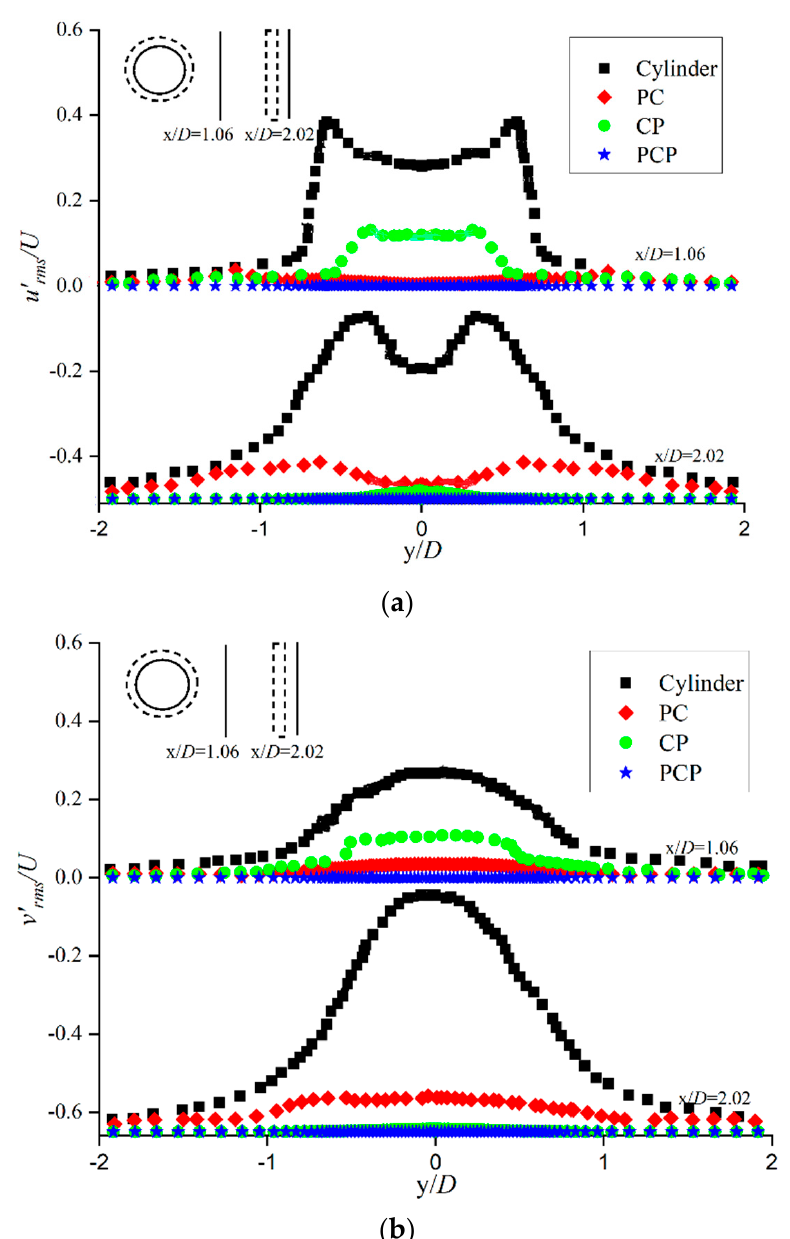
′ (cid:3293)(cid:3288)(cid:3294) (cid:48) (cid:48) (cid:3048) (cid:4594) (cid:3293)(cid:3288)(cid:3294) ; ( b ) (cid:3049) rms rms ; ( b ) v . Figure 17. Turbulence intensity profile at x/D = 1.06 and 2.02: ( a ) u U U (cid:3022) (cid:3022)